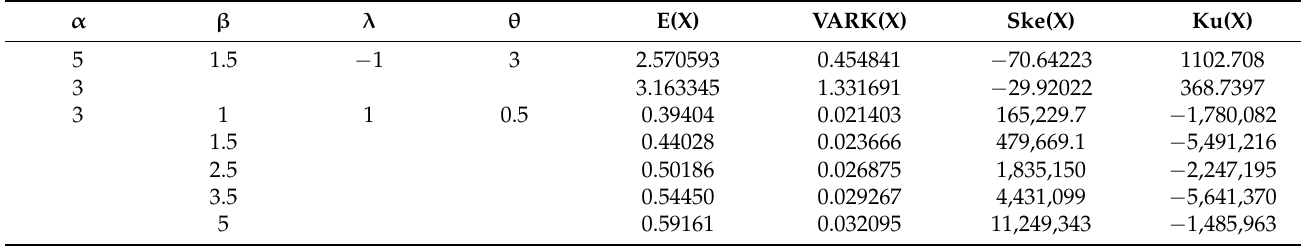
Table 2. E(X), VARK(X), Ske(X), and Ku(X) of the EGRRP